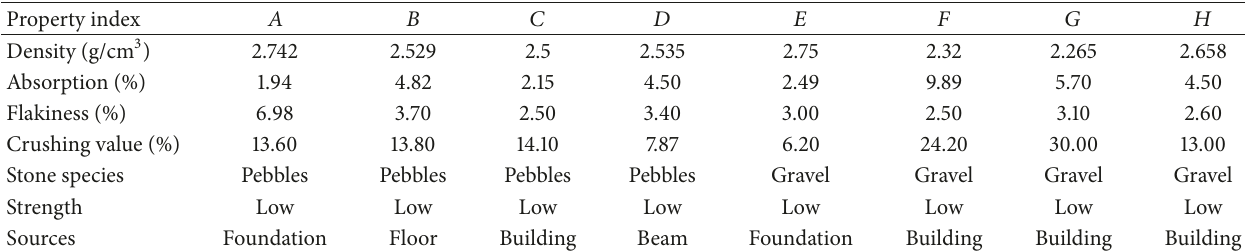
Table 2: Property data of RA from buildings.